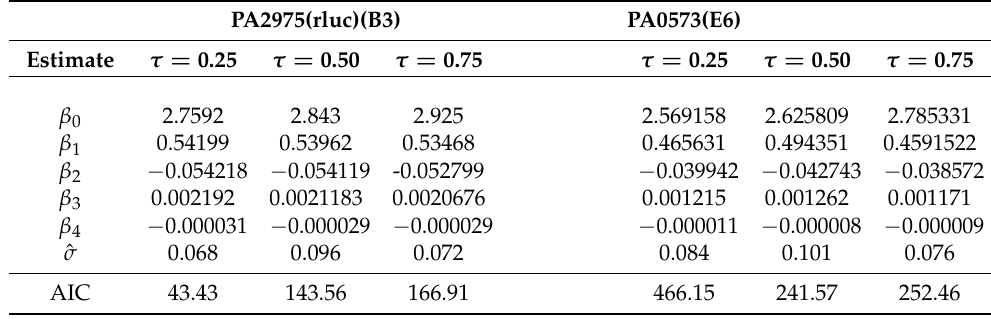
Table 5. Parameter estimates of quantile model for genes PA2975(rluc)(B3)and